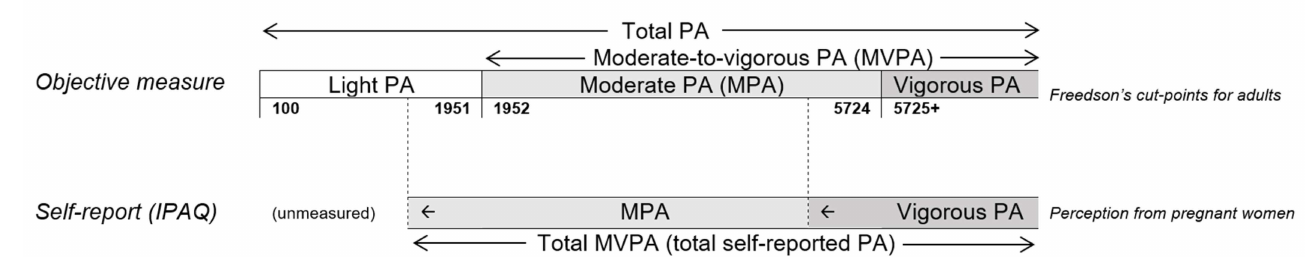
Figure 4. Hypothesised relationship between self-reported PA and accelerometer-based PA based on the scale of Freedson’s cut points. Notes: PA = physical activity. IPAQ = International Physical Activity Questionnaire. The positions of the cut-point only indicates the relative position but not their proportional